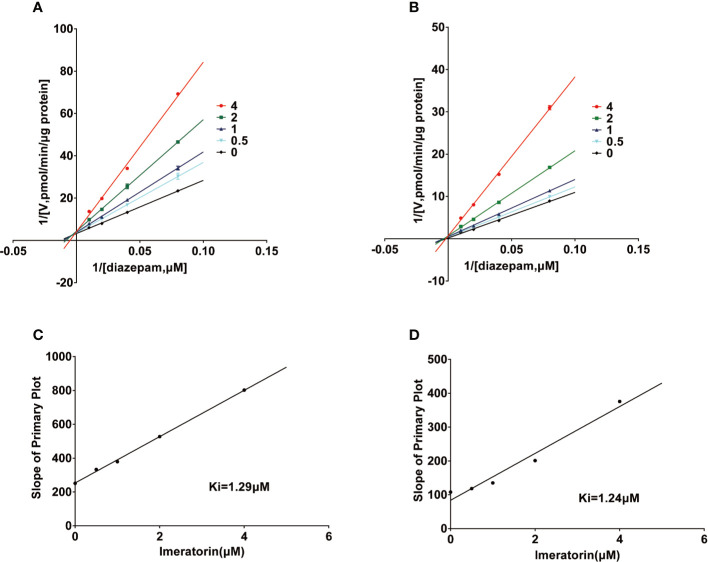
Lineweaver-Burk plot and the secondary plot for Ki in the inhibition of diazepam to nordazepam (A, C) and temazepam (B, D) by IMP with various concentrations RLMs (Mean ± SD, n=3).